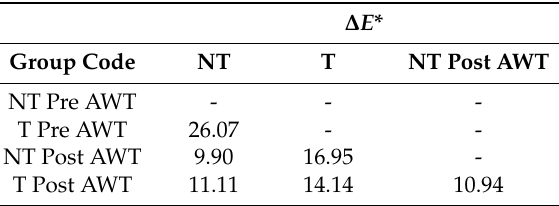
Table 3. ∆ E * measured among group code. Table 3. Δ E * measured among group code.